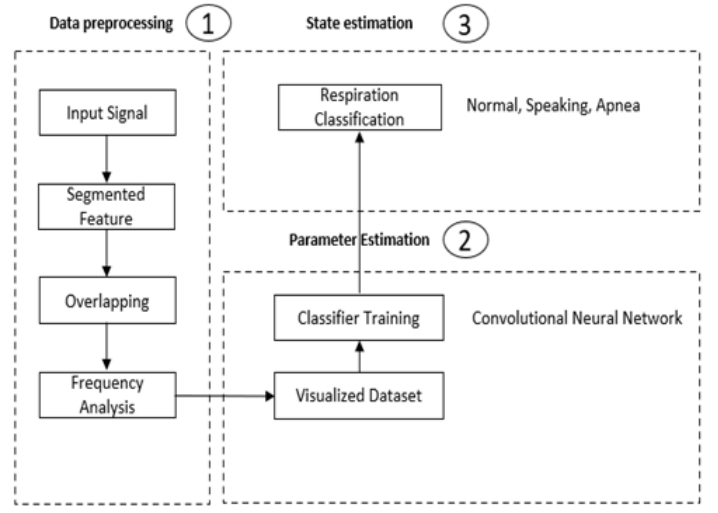
Figure 3. Suggested respiration state classification—overall flow